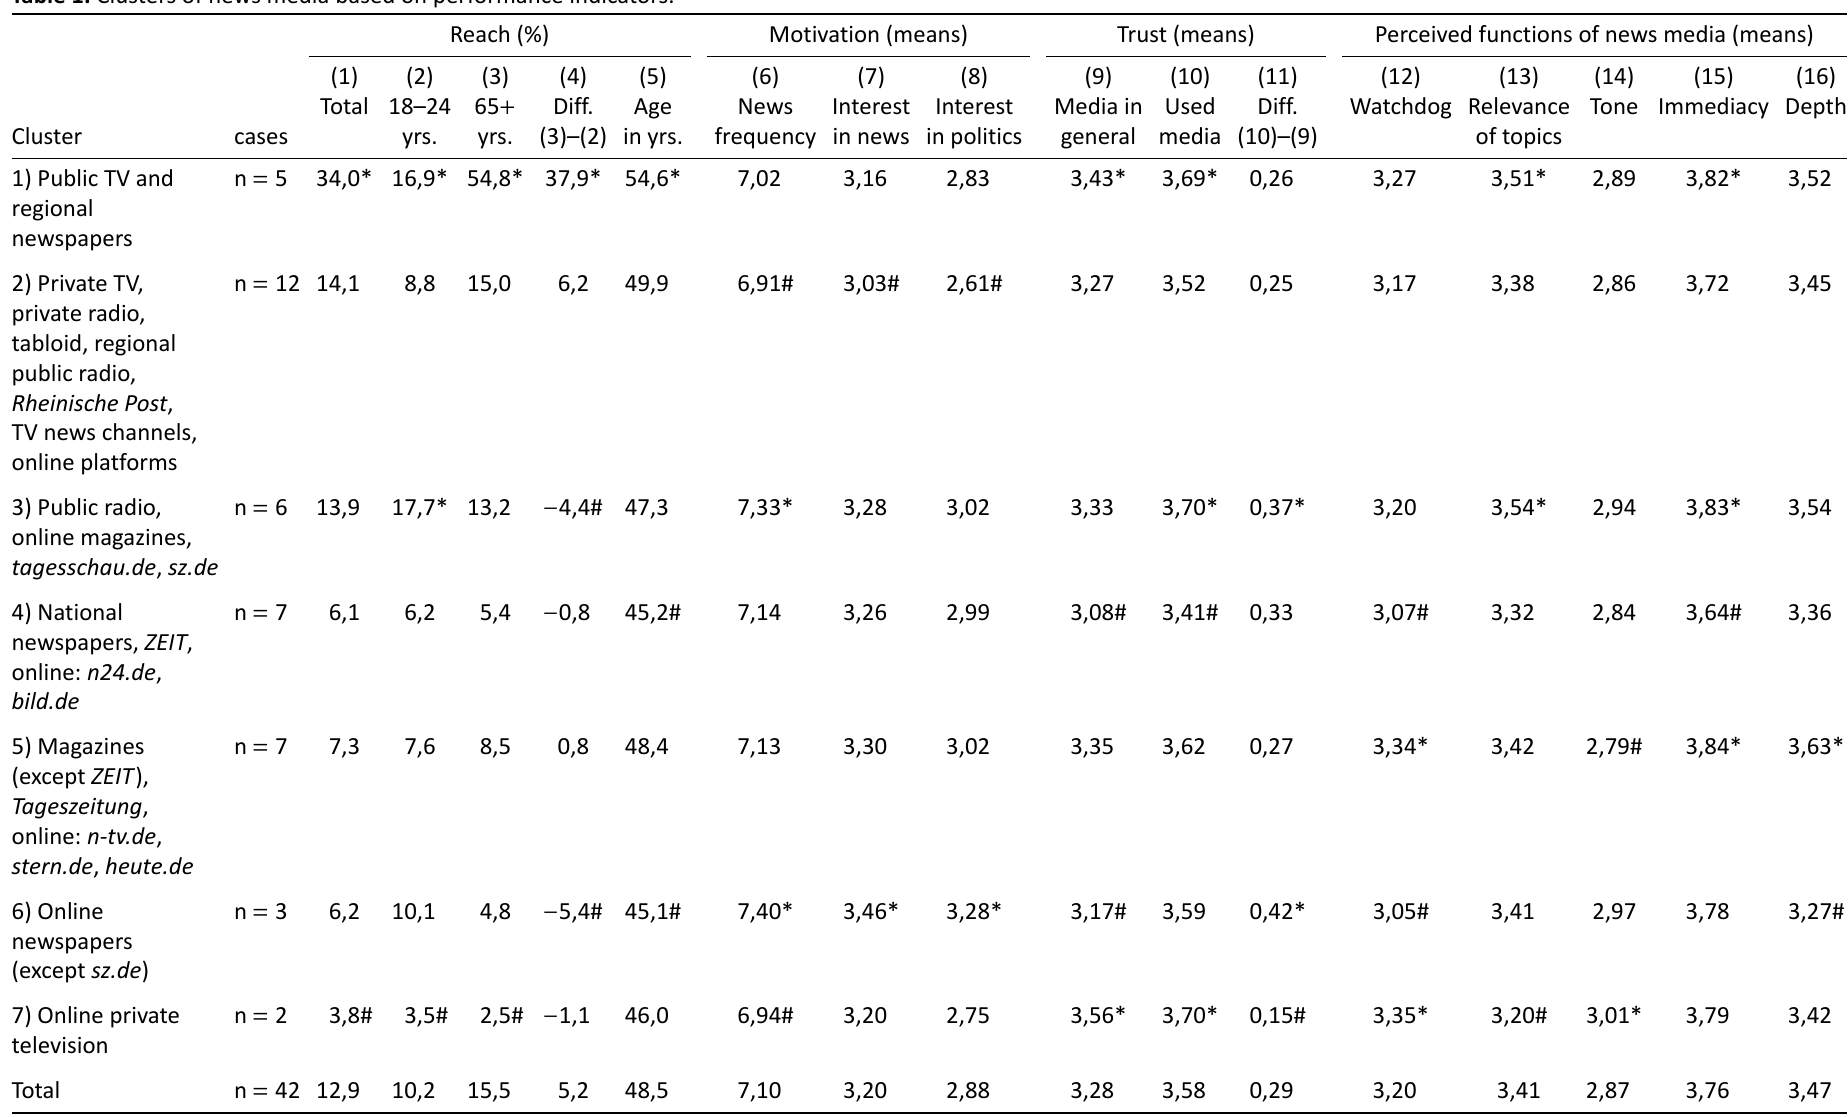
Table 1. Clusters of news media based on performance